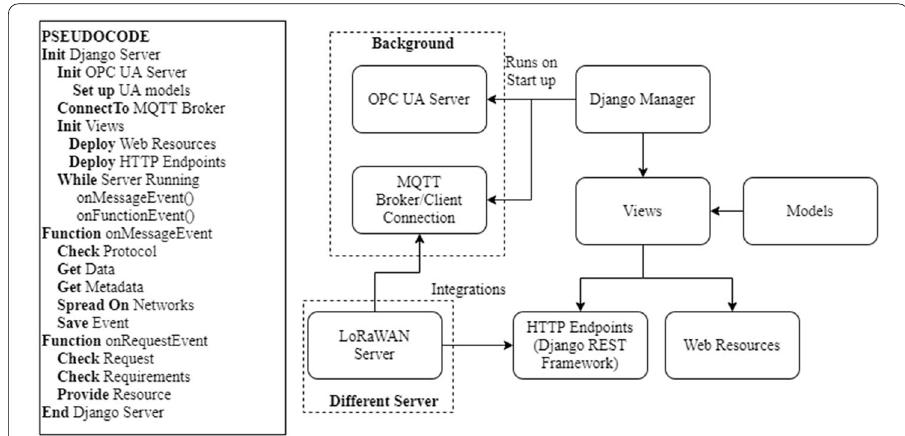
Fig. 3 Pseudocode and structure of resources of the IoT